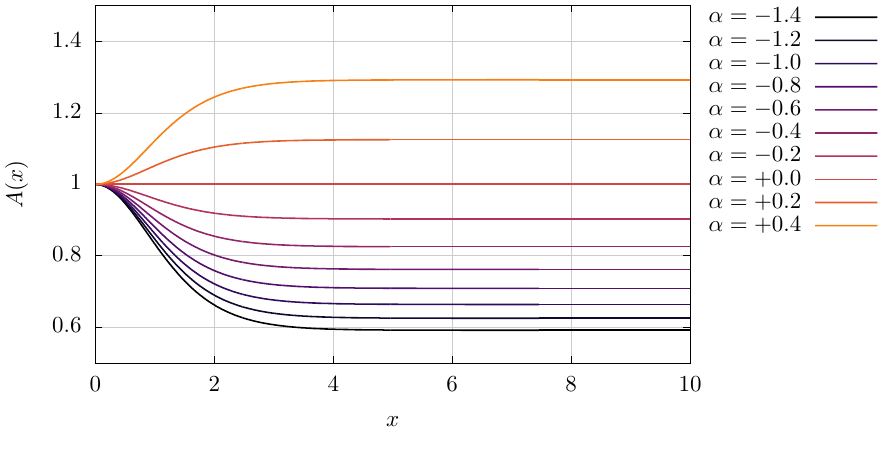
Figure 4 . The function A for several values of the impurity strength coupling (cid:11)